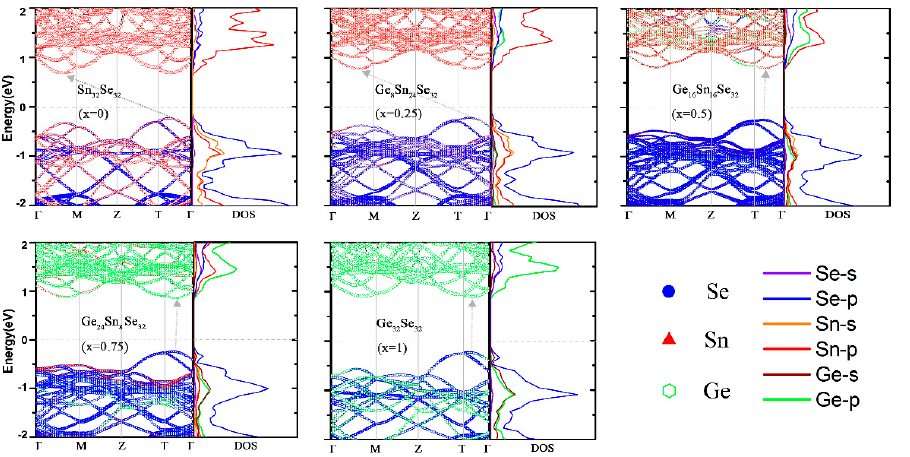
Figure 5. Atom-projected Band Structures and Density of States of the Different Ge x Sn 1-x Se (x = 0.0, 0.25, 0.5, 0.75, and 1.0) alloys. The direct/indirect bandgap is indicated by the grey arrow.